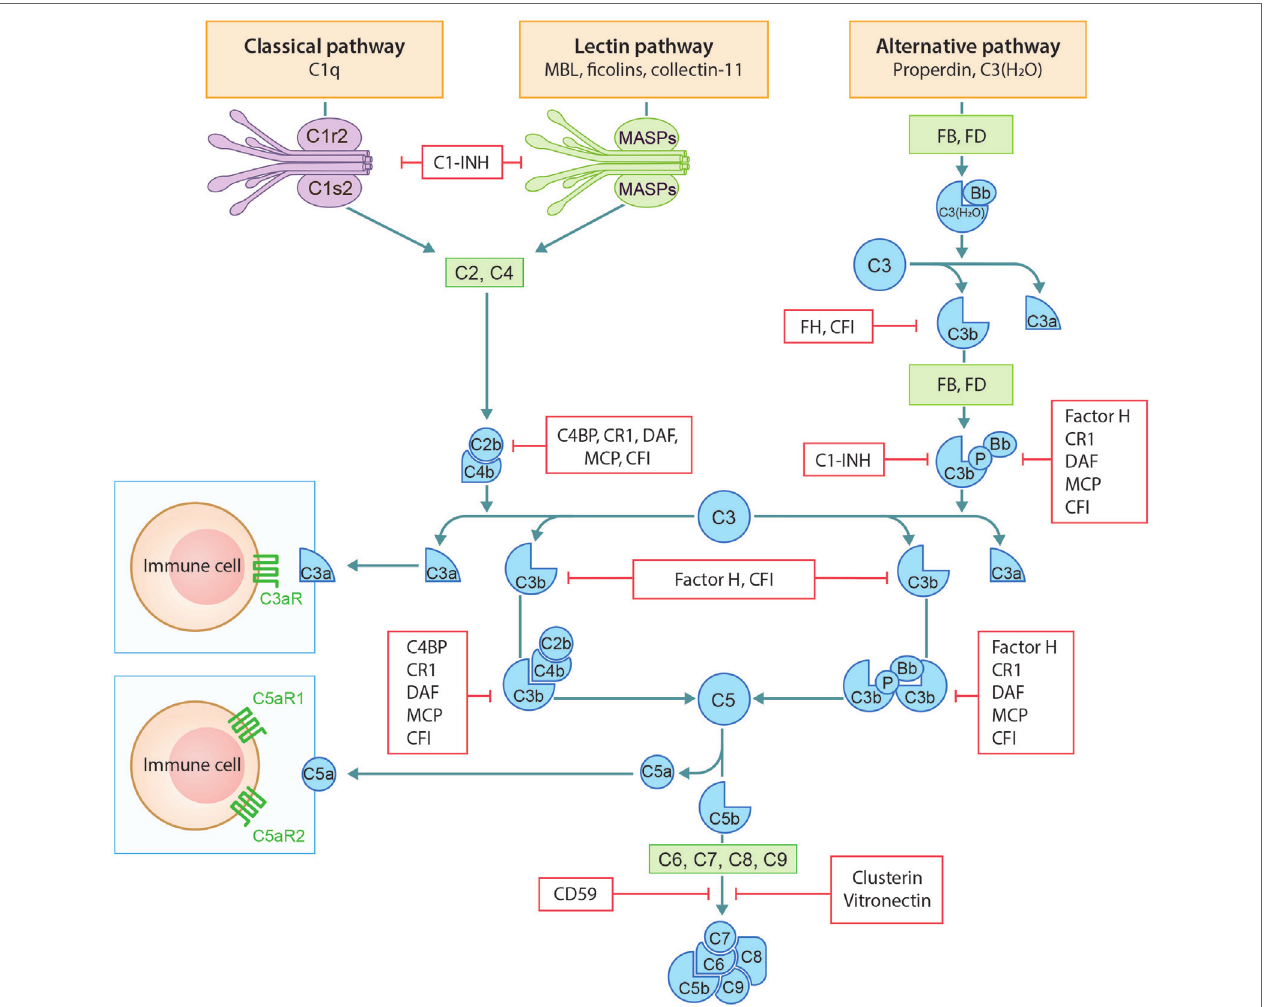
FigURe 1 | Schematic overview of the complement system: activation and regulation.